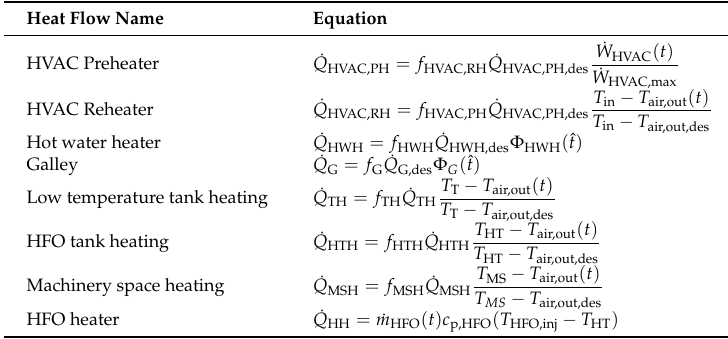
Figure A6. Hourly relative demand of hot water heating and galley. Table A5. Summary of the heat demand contributions and their